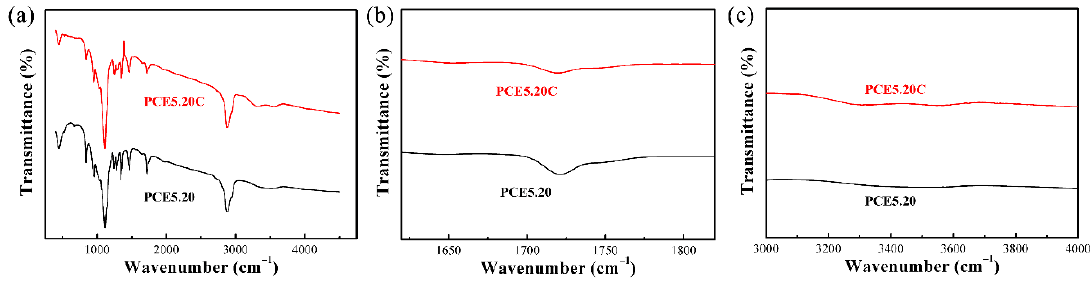
Figure 11. ( a ) FT-IR spectrum of PCE5.20 before and after 100 thermal cycles; ( b ) enlarged ( a ) at 1620–1820 cm − 1 ; and ( c ) enlarged ( a ) at 3000–4000 cm − 1 .